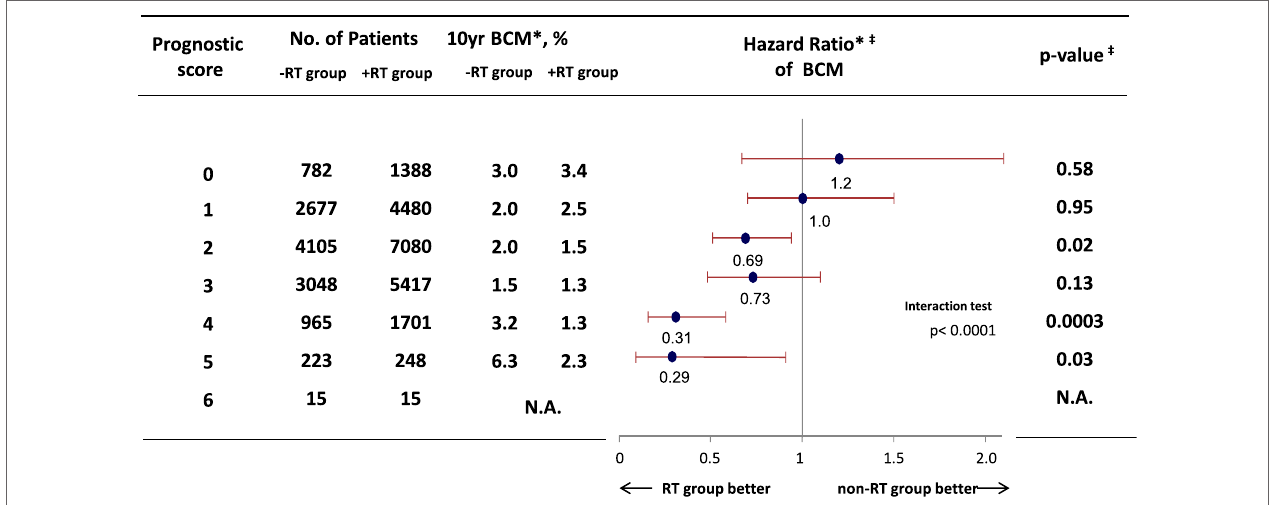
FiGURe 2 | Hazard ratio comparing BCM among patients who received breast-conserving surgery for ductal carcinoma in situ between RT group and non-RT group. *Weighted by inverse propensity score. ‡ Multivariate analysis adjusted by age of patients, year of diagnosis, race, tumor size, nuclear grade, and marital status. Abbreviation: RT, radiotherapy; BCM, breast cancer mortality. Sagara et al.